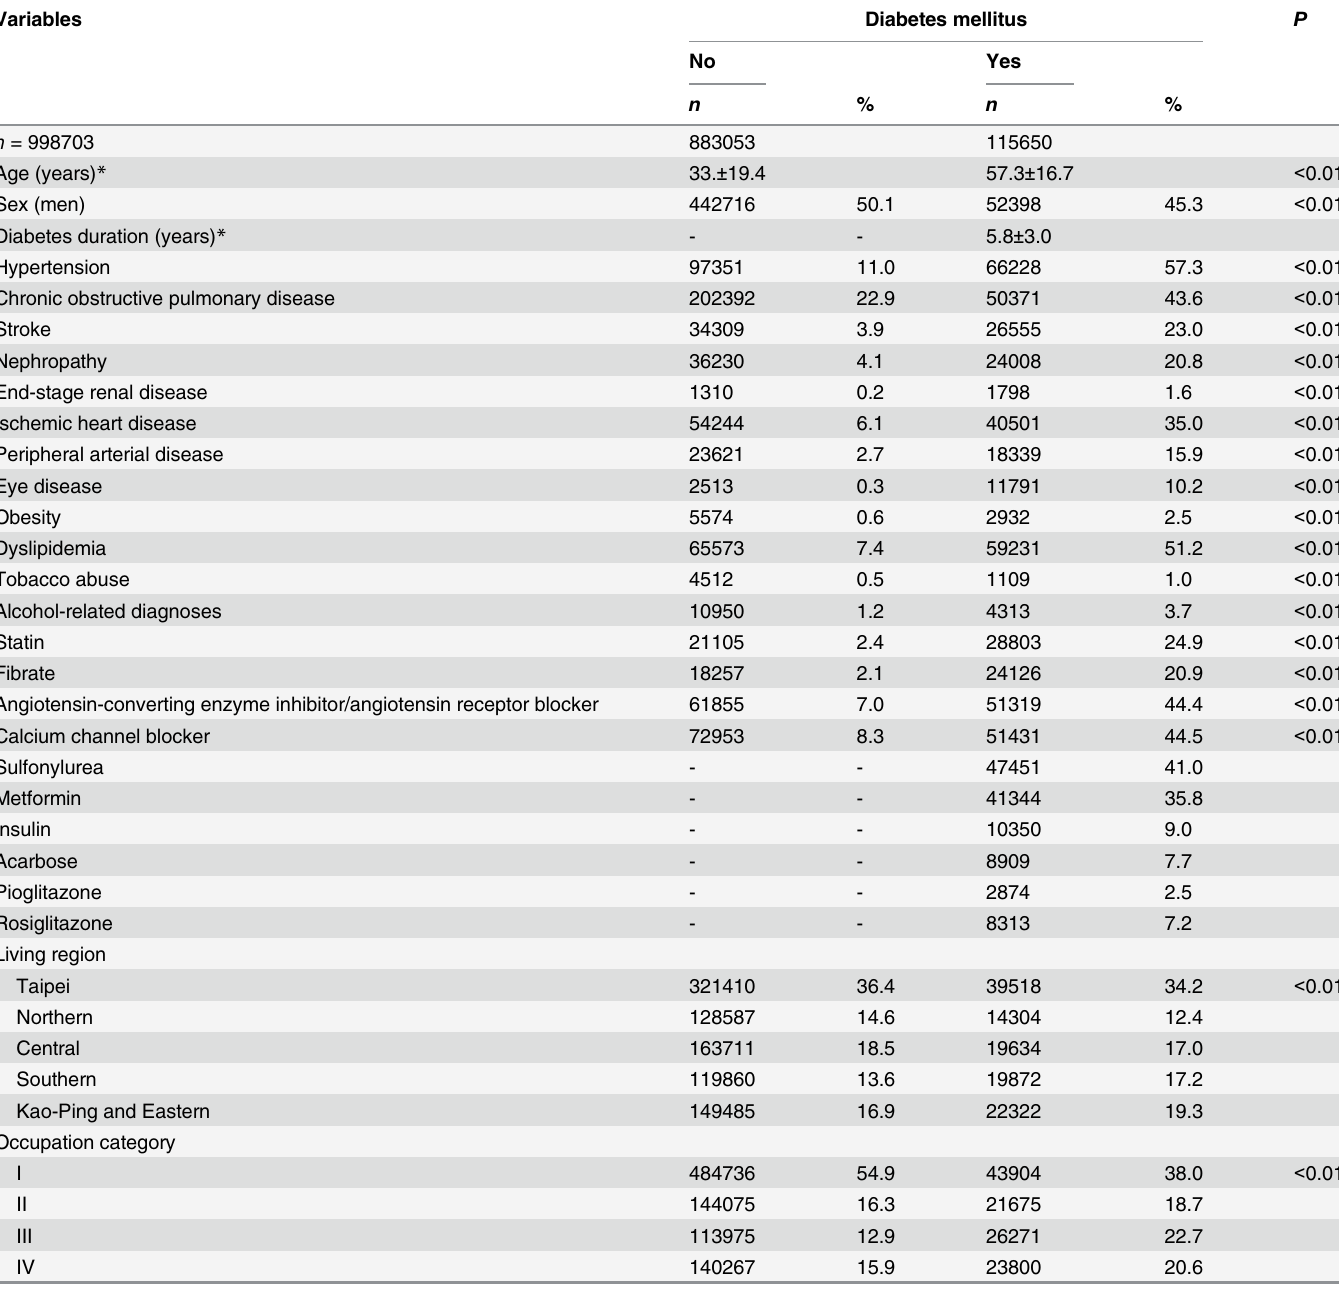
Table 1. Baseline characteristics of study subjects with and without diabetes